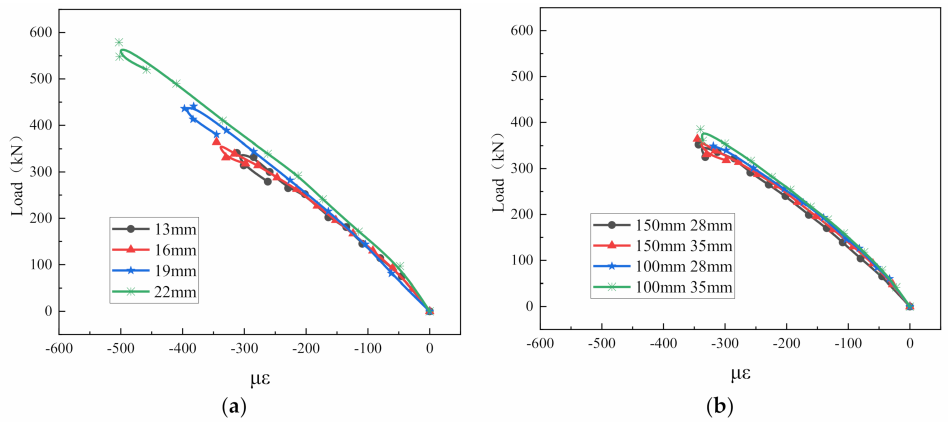
Figure 10. Load–strain curve of steel plate: ( a ) 150 mm stud spacing, 35 mm length; ( b ) 16 mm